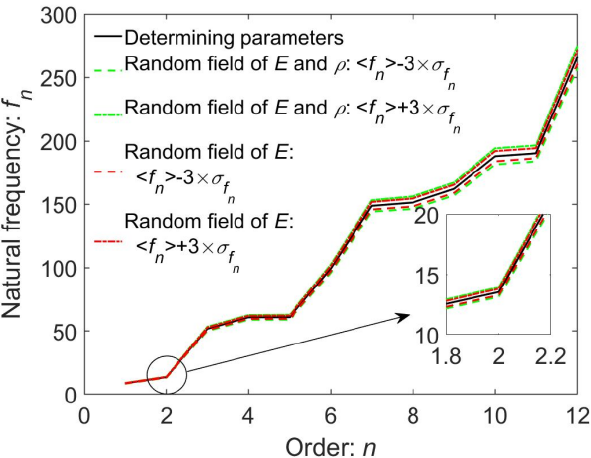
Figure 18. The value range of random natural frequencies for different random models computed by (cid:104) f n (cid:105) ± 3 × σ f n Table 3. The mean values and mean variances of random natural frequencies for different random models.